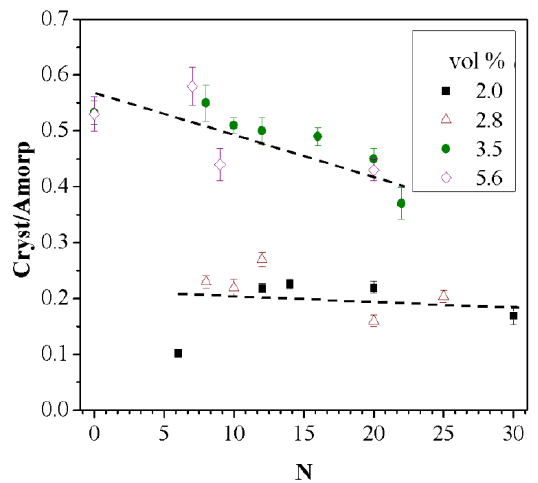
Figure 7. Total crystalline/amorphous ratio variation with respect to the processing parameter N at the indicated NP compositions. Lines are drawn as a visual